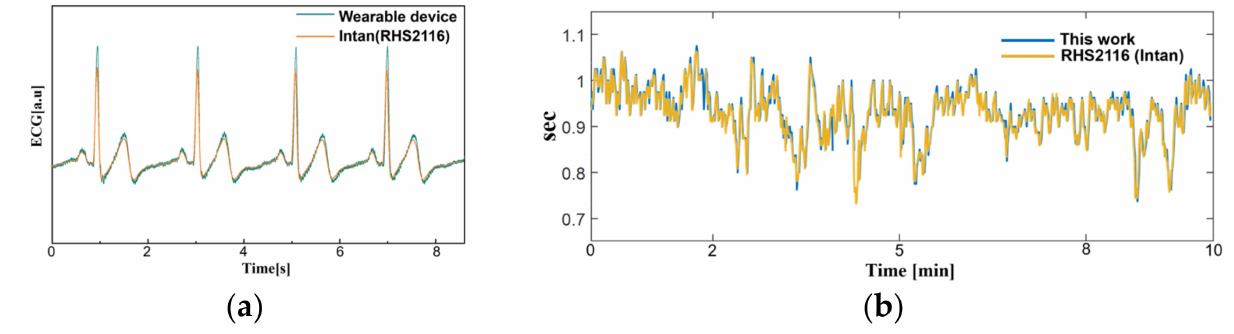
Figure 11. A comparison between this work and RHS2116 Stim/Recording System (Intan). ( a ) Time domain ECG acquired from this work and reference instrument at lead II orientation. ( b ) The R-R peak interval (heart rate) acquired for 10